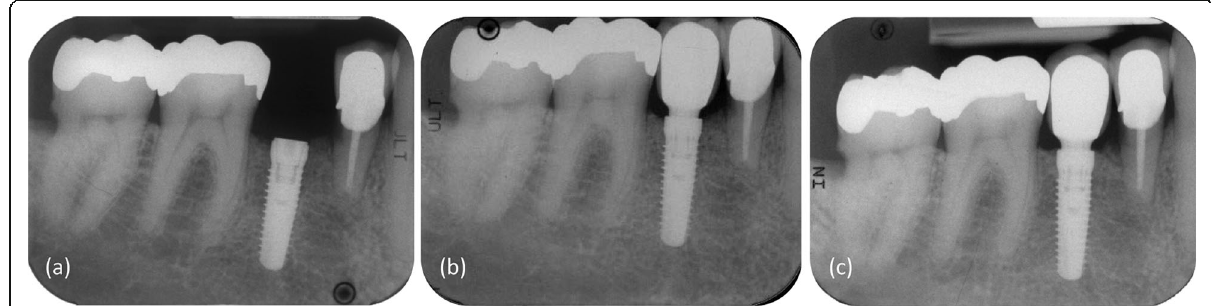
Fig. 3 Standardized peri-apical radiographs representing the bone level changes at the implant level: immediately post insertion ( a ), at loading (abutment/crown placement) ( b ), and at 5-year post-loading ( c )